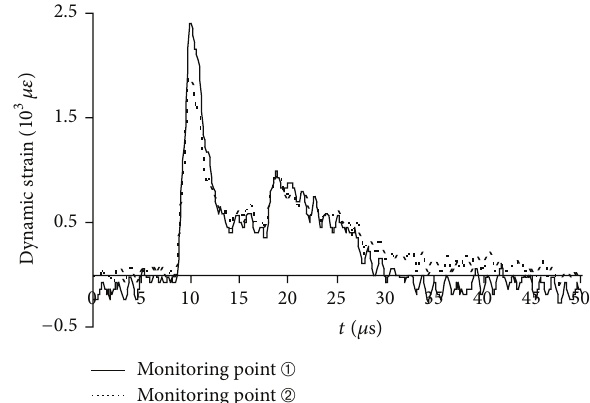
Figure 4: Measured curves of the reflected wave from the free